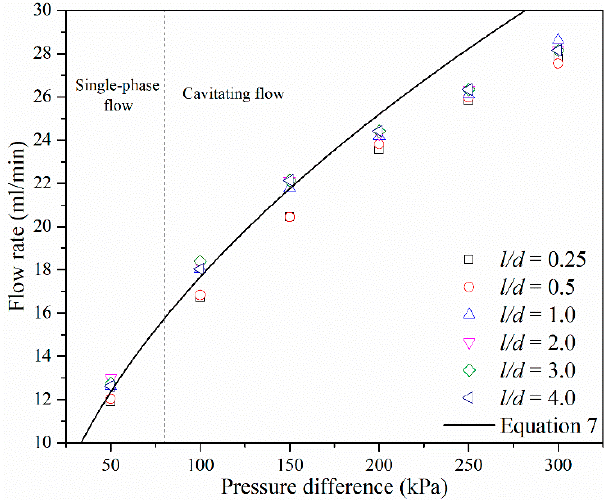
Figure 13. Flow rate vs. pressure drop for different l/d ratios.